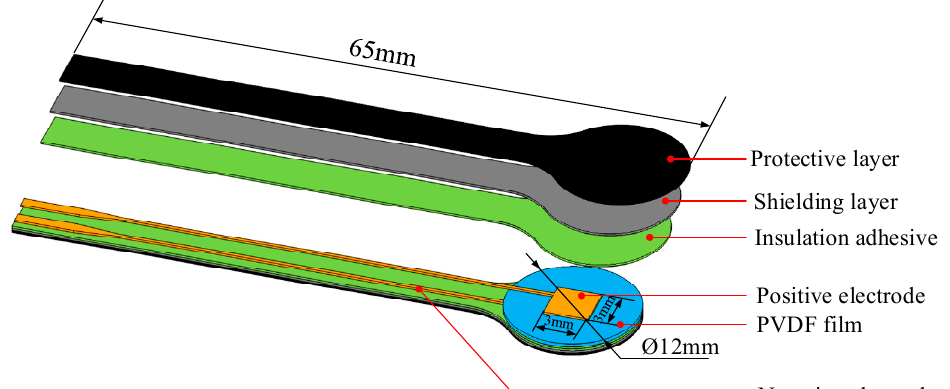
Figure 2. Expanded view of the PVDF sensor (single sensing point).